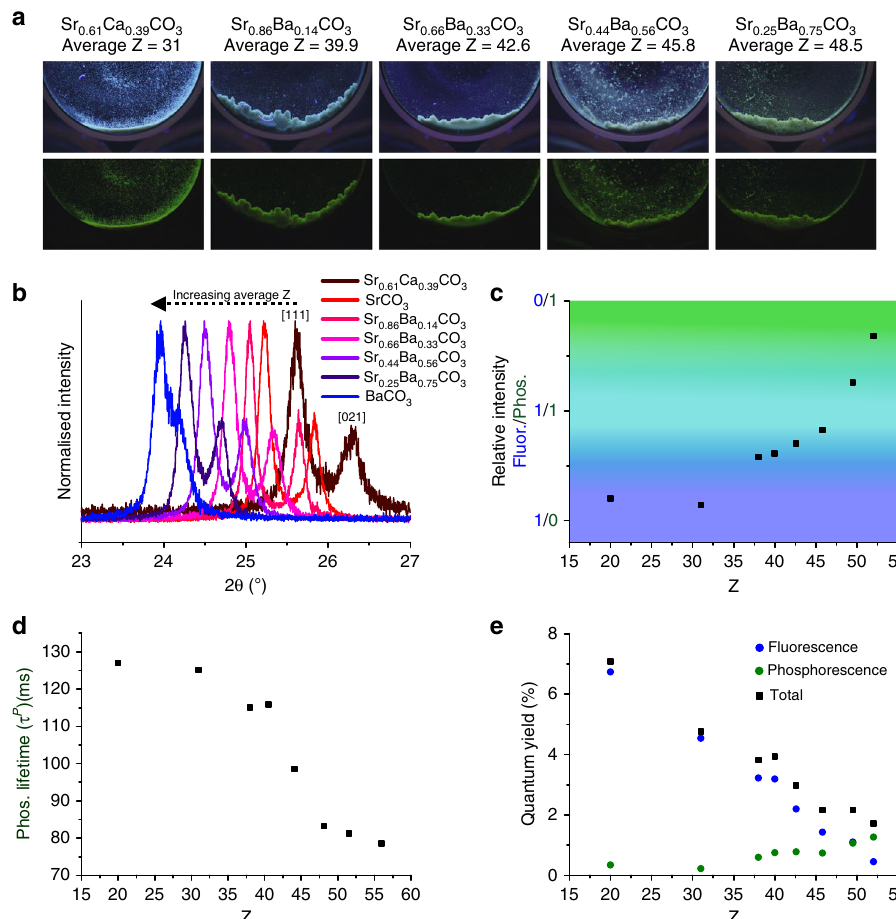
Fig. 7 Fine control over folic acid-derived carbon nanodot (F-CND) photoluminescent (PL) properties by changing the composition of the host crystal. a Photographs with, and immediately after the removal of, UV (365 nm) excitation of F-CND nanocomposites with different Ca/Sr/BaCO 3 solid solutions as labelled. b X-ray diffraction (XRD) patterns in the range 2 θ = 23 – 27° of samples, where the peak centre for [111] re fl ection is shown to move to a smaller angle with an increasing average Z of the host. c Relative room temperature phosphorescence (RTP) intensity values obtained from background-subtracted normalised SS-PL spectra showing the progressive activation of RTP with increasing Z. d Lifetime measurements obtained by video stroboscopy showing shorter lifetimes as Z increases. e Fluorescence quantum yields decrease with Z, whereas phosphorescence/RTP quantum yields increase with Z. Overall, the total quantum yield